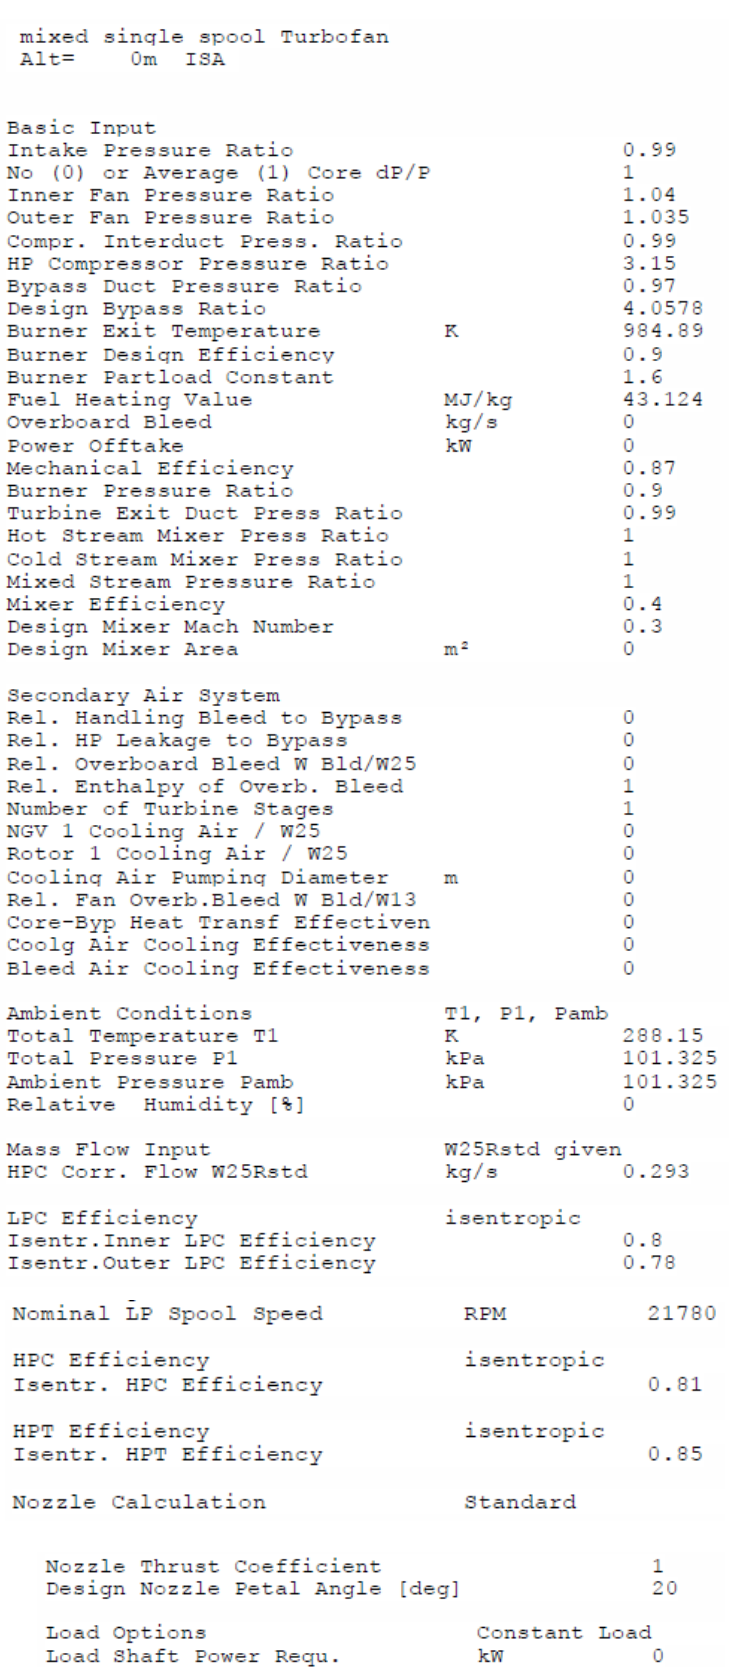
Figure A7. GasTurb Turbofan engine model input parameters—fan at 13,068 RPM.